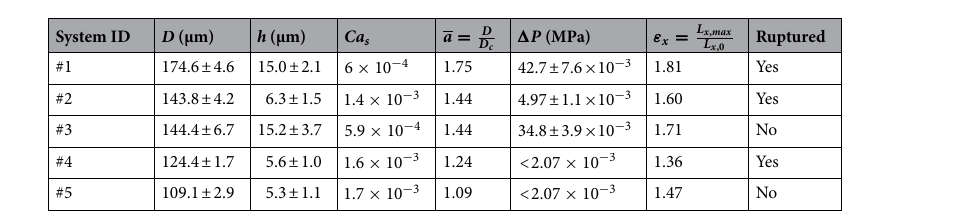
Figure 8. Evolution of the microcapsule position and configuration as it flows through the constriction. System #4, D = 124.4 μm and h = 5.6 μm ( a = 1.75 and Ca s = 6.0 × 10 content.